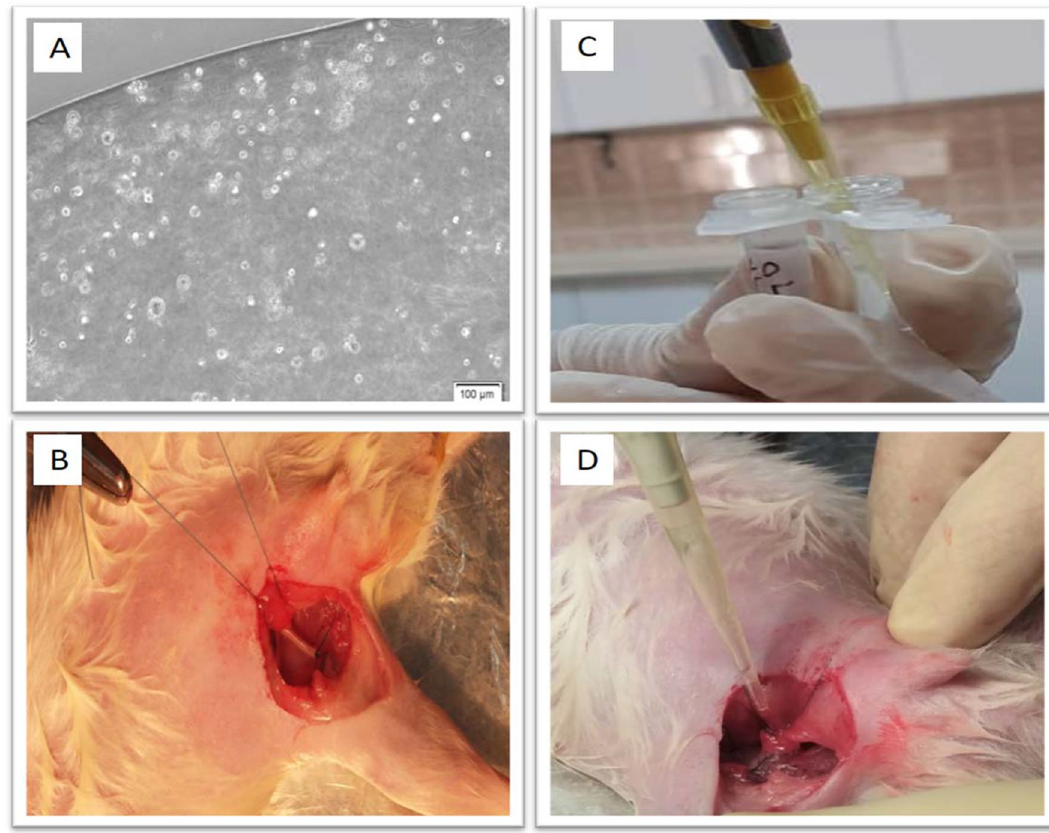
Figure 2. Preparation and implantation of the hydrogel scaffold. ( A ) Representative image showing the morphology and viability of the cells encapsulated within the hydrogel. ( B ) A representative image of the resected area of the femoral artery. ( C ) Photograph showing the addition of 15 μl hydrogen peroxide to the cells encapsulated within the hydrogel . ( D ) Representative photograph showing implantation of the resultant mixture into the resected area of the femoral